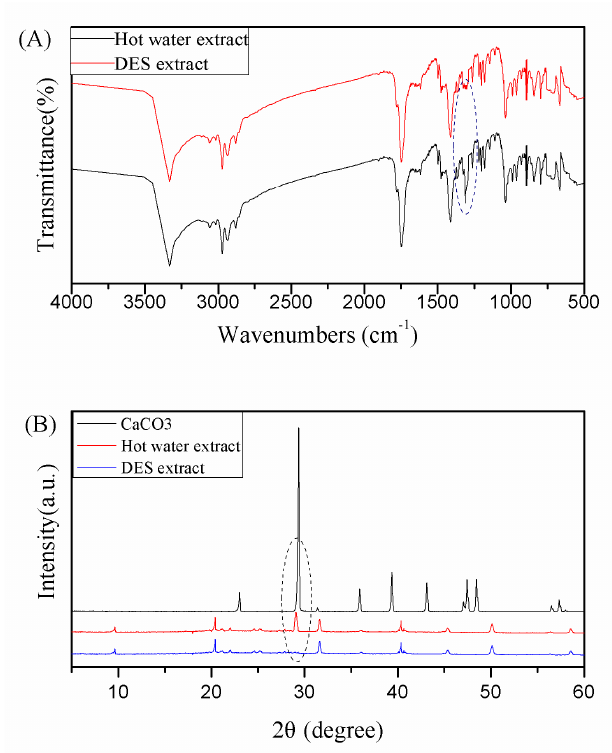
Figure 2. ( A ) The FT-IR spectrum of hot water extracted S. horneri polysaccharides and DESs extracted S. horneri polysaccharides; ( B ) X-ray curve of CaCO 3 , hot water extracted S. horneri polysaccharides and DESs extracted S. horneri polysaccharides.